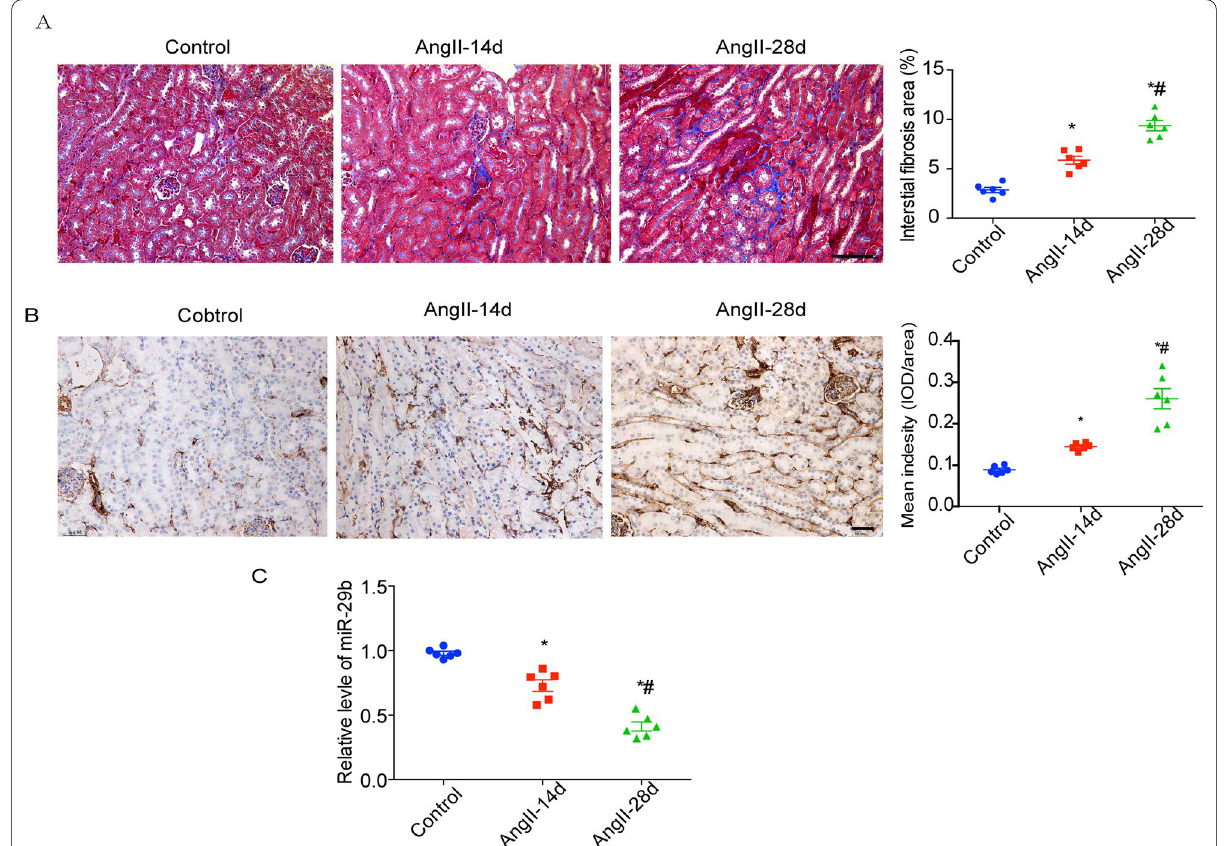
Fig. 2 Decrease of miR‑29b levels in mouse kidney during angiotensin II‑induced renal fibrosis. Representative images of Masson trichrome staining ( A ) and a‑SMA immune stain ( B ) of kidney with saline or angiotensin II infusion at different time points. Magnification, histogram represents quantitative analysis of tubular interstitial fibrosis. Results are presented as mean group. # P < 0.01 compared with angiotensin II infusion group (Day 14). Each group consisted of six mice. Scale bar 50 μm. C Real‑time PCR further confirmed the decrease in miR‑29b levels in renal tubular epithelium among different groups. Control, mice were treated with saline. AngII‑14d, mice were treated with continuous angiotensin II infusion for 14 days. Ang II‑28d, mice were treated with continuous angiotensin II infusion for 28 days. * P < 0.05 compared with control group. # P < 0.05 compared with angiotensin II infusion group (Day